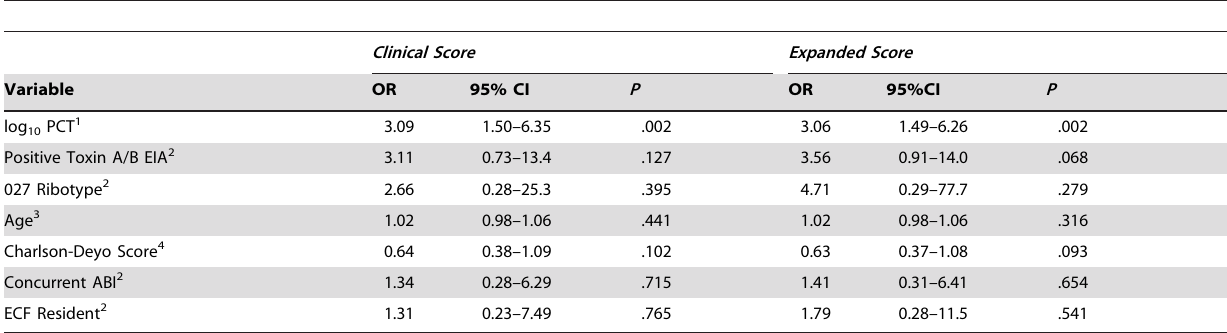
Table 2. Odds ratios for predictors of CDI severity scores based on multiple logistic